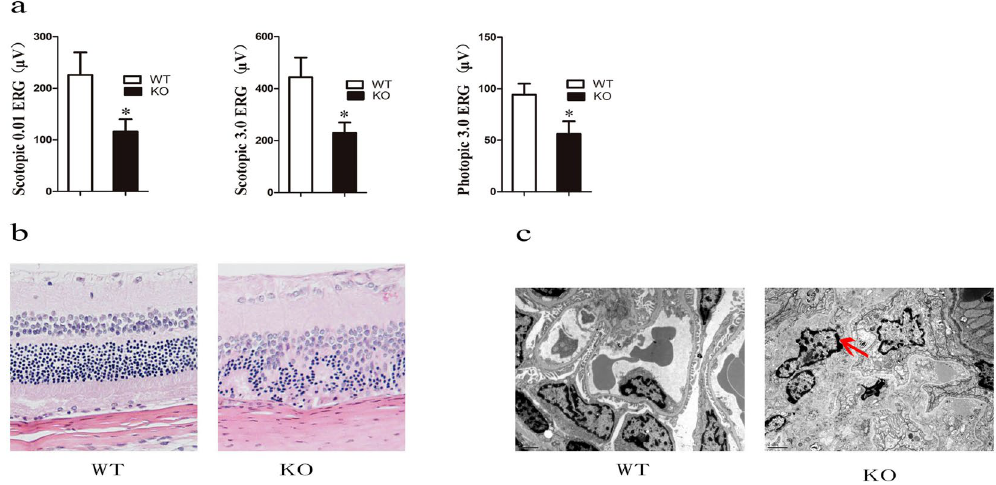
Figure 5. Changes in eyes and kidneys of Lamp2 y/ − rats. ( a ) ERG analysis; ( b ) Paraffin sections with HE staining of retina; ( c ) Ultrastructure of the kidney. WT, wild-type male rats; KO, Lamp2 y/ −